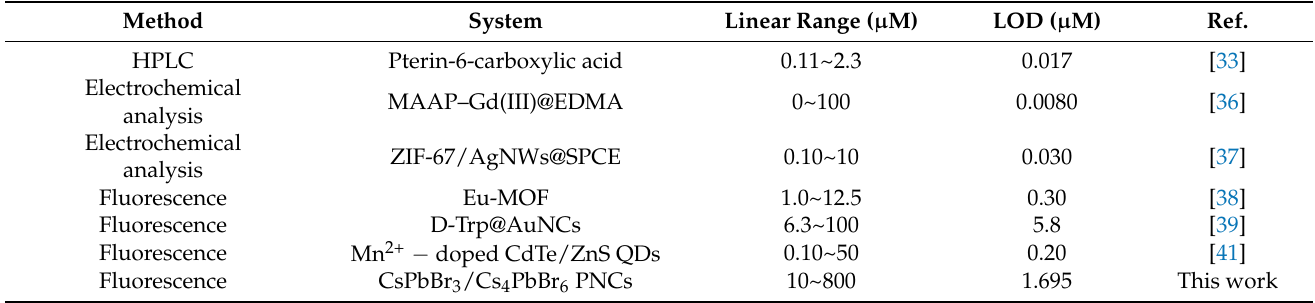
Table 1. The comparison of the proposed method with other methods of FA determination.